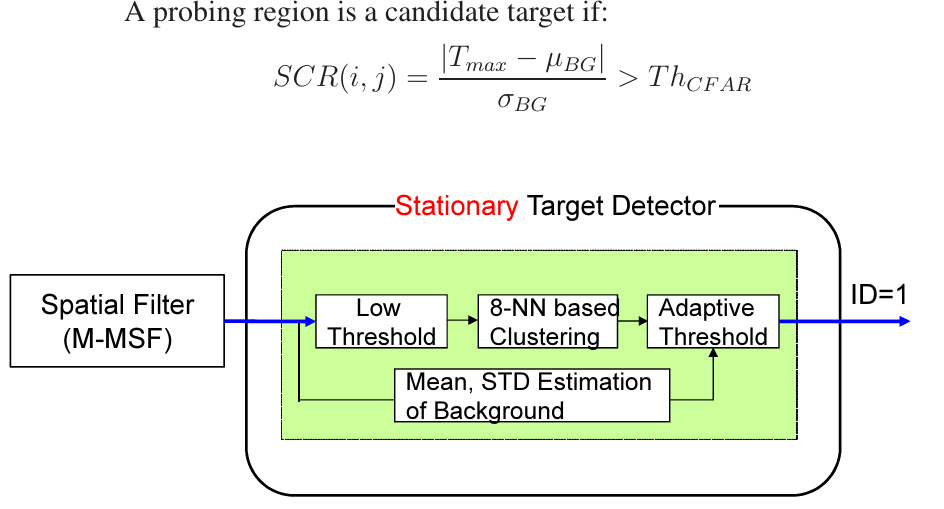
Figure 12. Stationary target candidate detector: given the M-MSF filtered image, spatial targets are detected using a hysteresis threshold constant false alarm (H-CFAR)